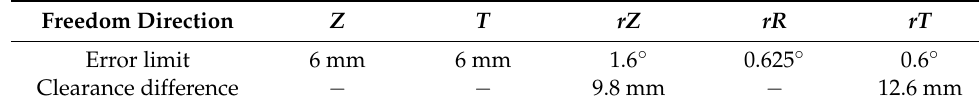
Table 7. Error limits in the single degree of freedom direction.